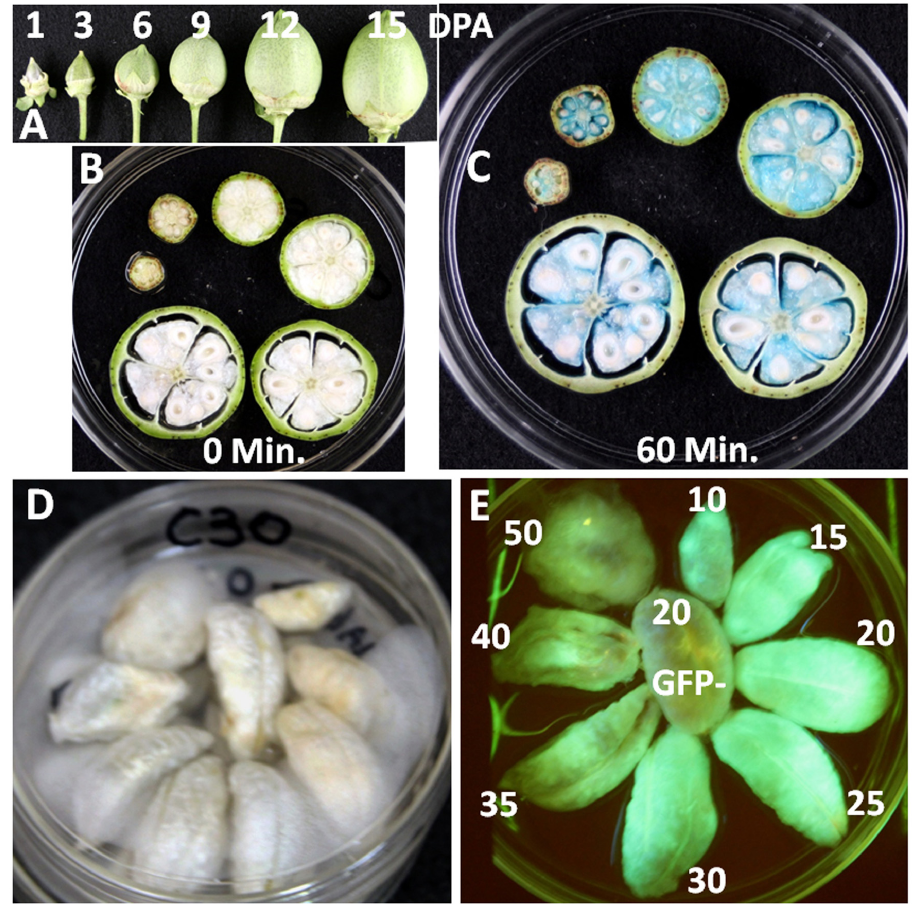
Fig 4. Photographs of cross-sections of cotton balls and fiber tissues harvested at different days post anthesis (DPA), showing the expression patterns of reporter gene activities in C22 (Expansin::GUS) and C30 (CelA1::GFP) transgenic plants. (A) photo of cotton balls harvested from a transgenic plant line at 1, 3, 6, 9, 12 and 15 DPA; Thin cross sections of those C22 cotton bolls in A, showing the fiber tissues (B) before GUS staining and (C) after 60-min GUS staining. (D) Fiber tissues harvested from one chamber of cotton bolls of a C30 transgenic plant line at 10, 15, 20, 25, 30, 35, 40, 50 DPA and (E) the Green- Fluorescence-Protein glowing, showing the cellulose syntheses A1 gene activity during cotton fiber development; fiber tissue at the center was from a 20-DPA boll of a null plant, serving as a GFP negative